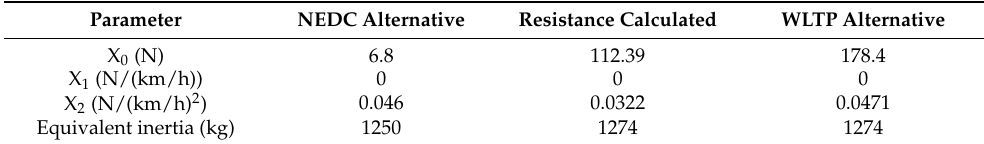
Table 3. Coefficients of resistance and equivalent inertia.